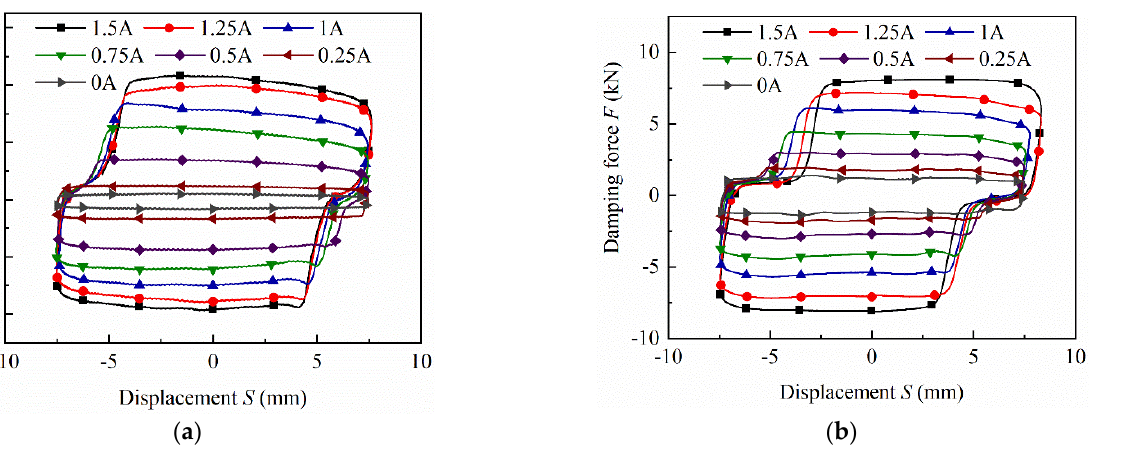
Figure 19. Damping force versus displacement under different currents: ( a ) initial; ( b ) optimal.